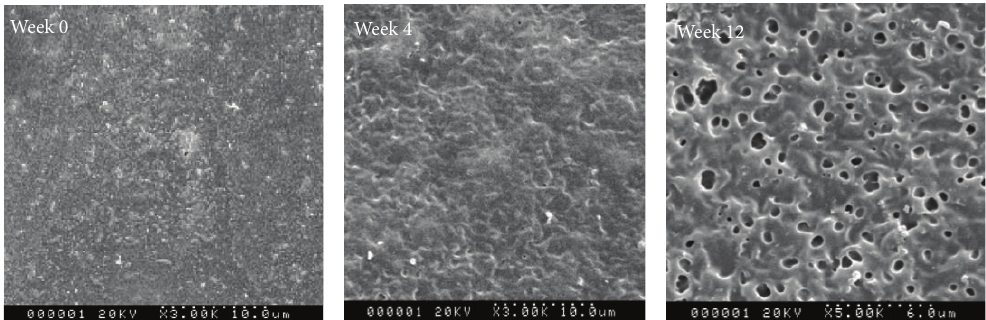
Figure 10: SEM micrographs of PUHE-25 film at various stages of degradation at pH